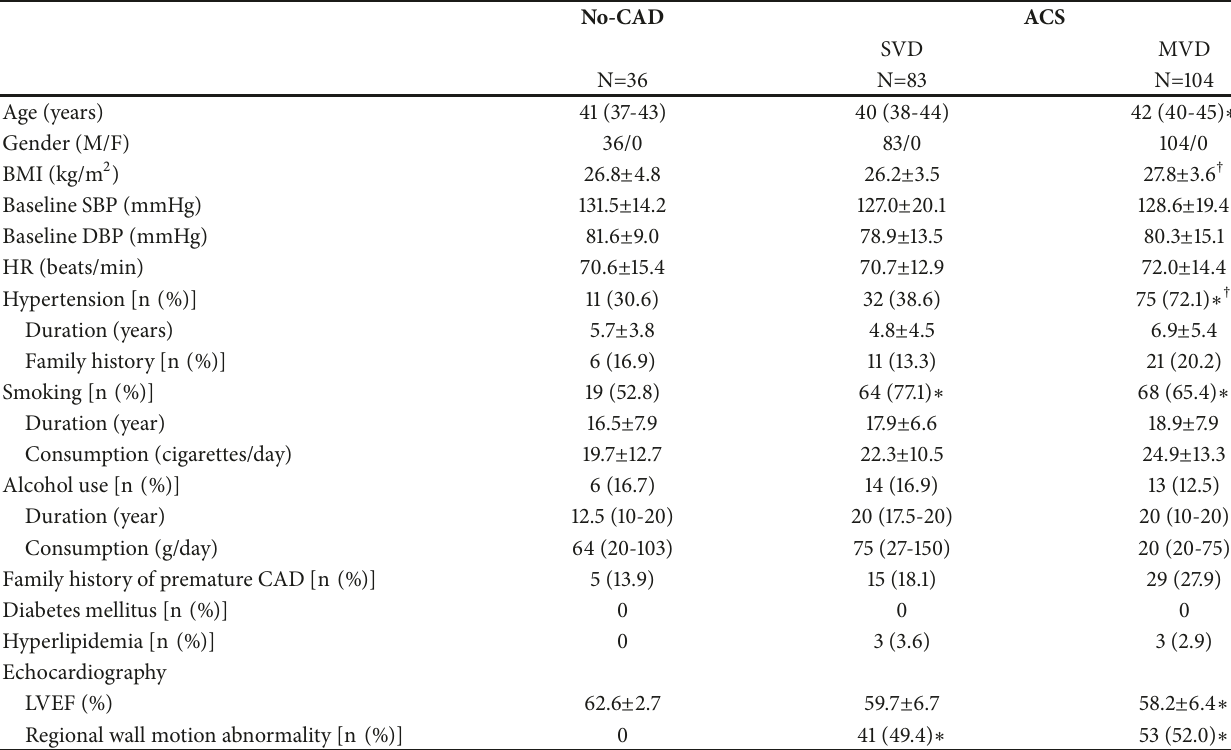
Table 1: Clinical characteristics.